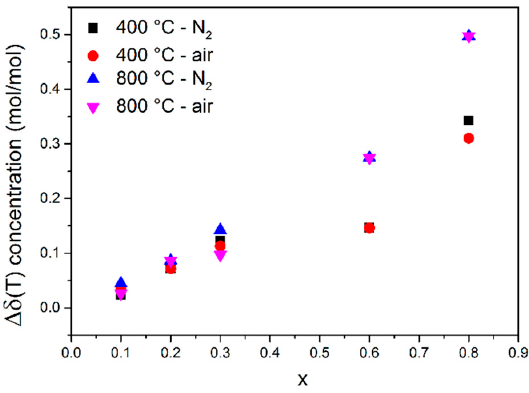
Figure 5. Total molar oxygen vacancy concentration ∆ δ ( T ) tot as a function of iron content in SrTi 1- x Fe x O 3-x/2- δ samples collected for two chosen temperatures: − 400 and 800 °C.